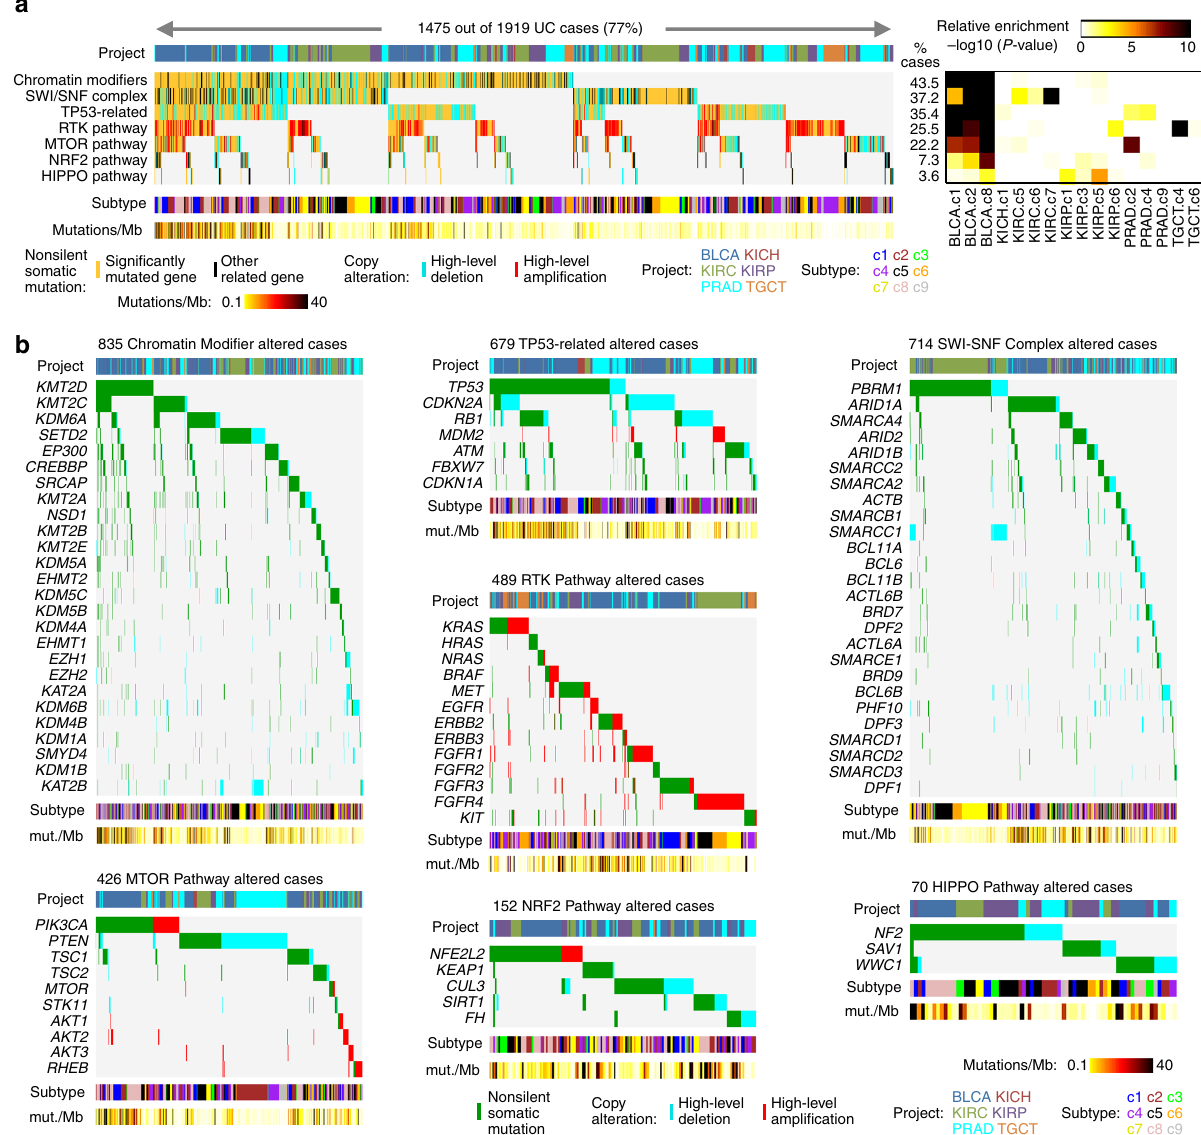
Fig. 4 Somatic mutations and associated pathways across pan-urologic cancer types and genomic subtypes. a Pathway-centric view of nonsilent gene mutations and copy alterations in urologic cancers ( n = 1919 urologic cancer cases with available exome sequencing data), involving key pathways and signi fi cantly mutated genes previously implicated in these cancers 5, 6, 10, 52 . Panel on the right represents signi fi cance of enrichment (one-sided Fisher ’ s exact test) of gene alteration events for each pathway within any particular genomic subtype/cancer type vs. the rest of the tumors. b For the pathways represented in part a, mutation and copy alteration events involving each gene included in the pathway. For parts a and b , “ high-level ” deletion and “ high-level ” ampli fi cation respectively approximate total copy loss and copy levels more than 2× greater than that of wild-type (based on GISTIC thresholded values). See also Supplementary Fig. 4 and Supplementary Data